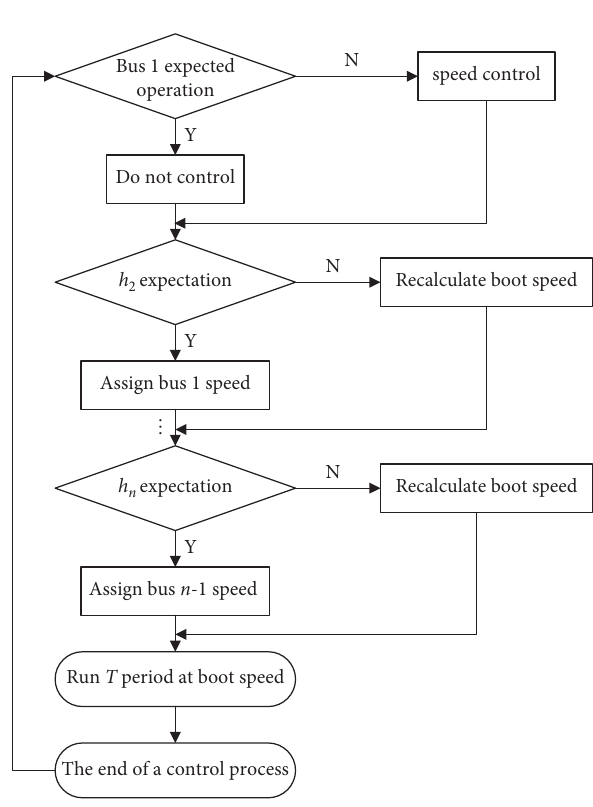
Figure 2: One-time control flow chart of the full-length